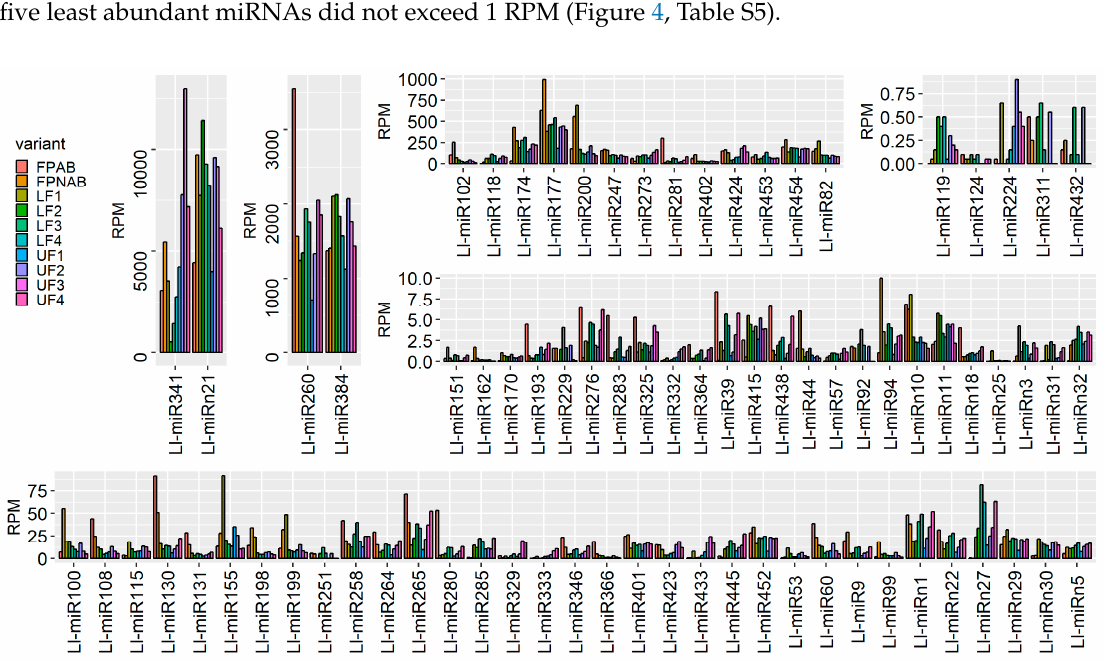
Figure 4. Diversity of miRNA expression (reads per million, RPM) in yellow lupine flowers. Complete data concerning differential miRNA expression in the experiment described herein, divided into six groups, depending on their expression maxima listed in order of appearance from left to right, and top to bottom: over 10,000 RPM, 2000–10,000 RPM, 100–2000 RPM, up to 1 RPM, 1–10 RPM, 10–100 RPM.2.6. Identification of phased siRNA in Yellow Lupine.